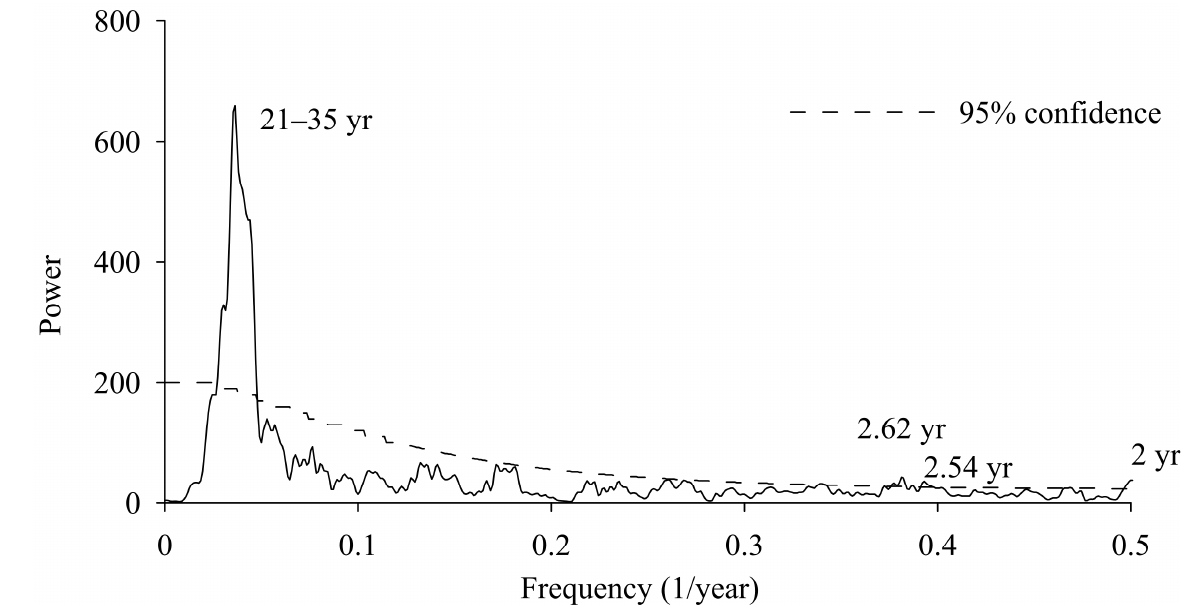
Figure 6. MTM analyses for the reconstructed summer minimum temperature.